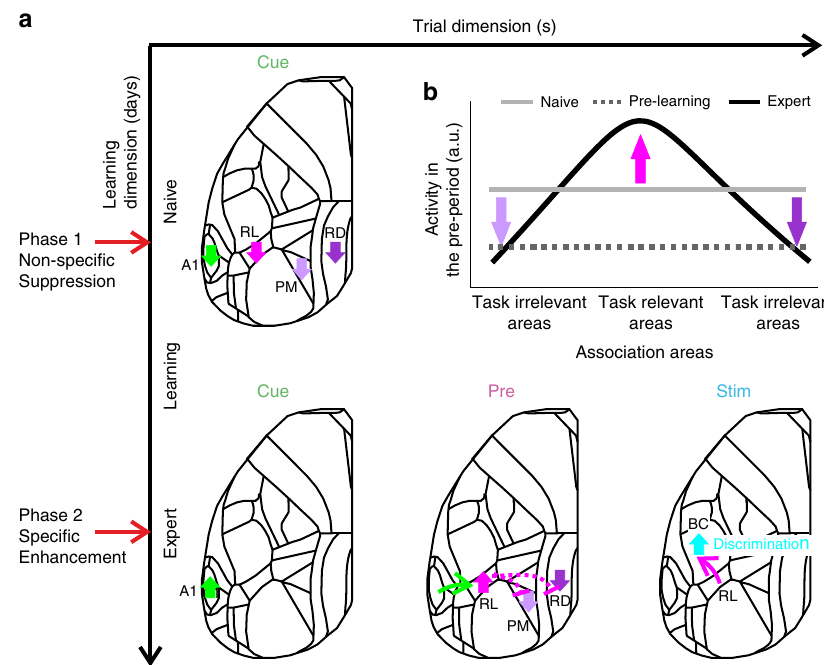
Fig. 8 Learning starts with a general suppression phase followed by a speci fi c enhancement phase. a A schematic illustration of the main cortical changes with regard to the two temporal scales: trial ( x -axis) and learning ( y -axis). Two phases occur across learning: before mice actually learn to discriminate between textures, association areas display non-speci fi c suppression of activity in response to the cue (phase 1: non-speci fi c suppression). Only later, as mice learn the task, a speci fi c sequential pattern is enhanced: starting from A1 in response to the cue, then RL just before the texture touches the whiskers, and BC during texture touch (phase 2: speci fi c enhancement). Association areas PM and RD speci fi cally remain suppressed. b Schematic diagram showing the distribution of activity across association areas during the pre-period (i.e. in preparation of the upcoming texture touch) for the naïve (gray), pre-learning (dashed gray), and expert (black)